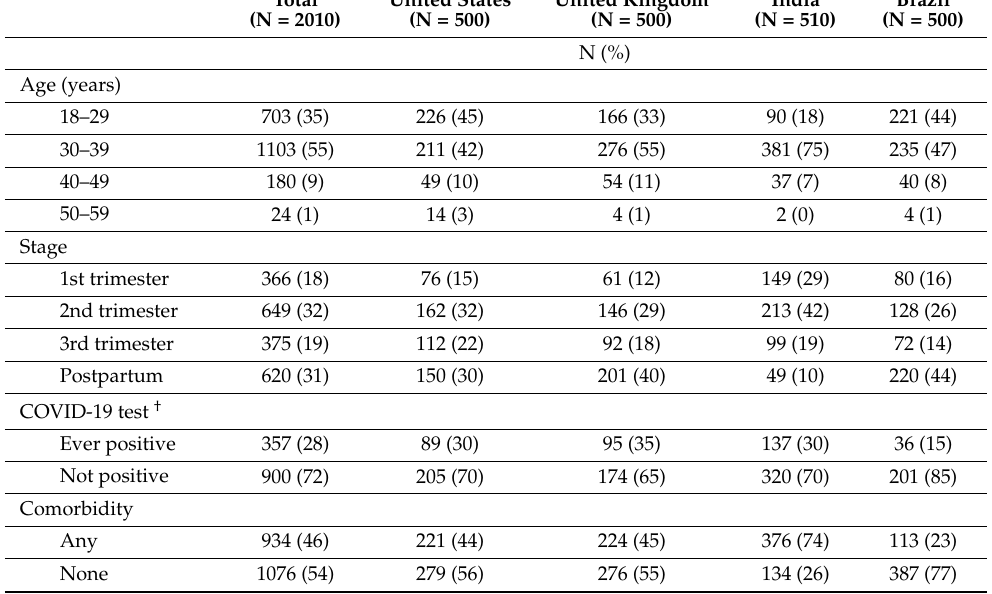
Table 1. Baseline demographic